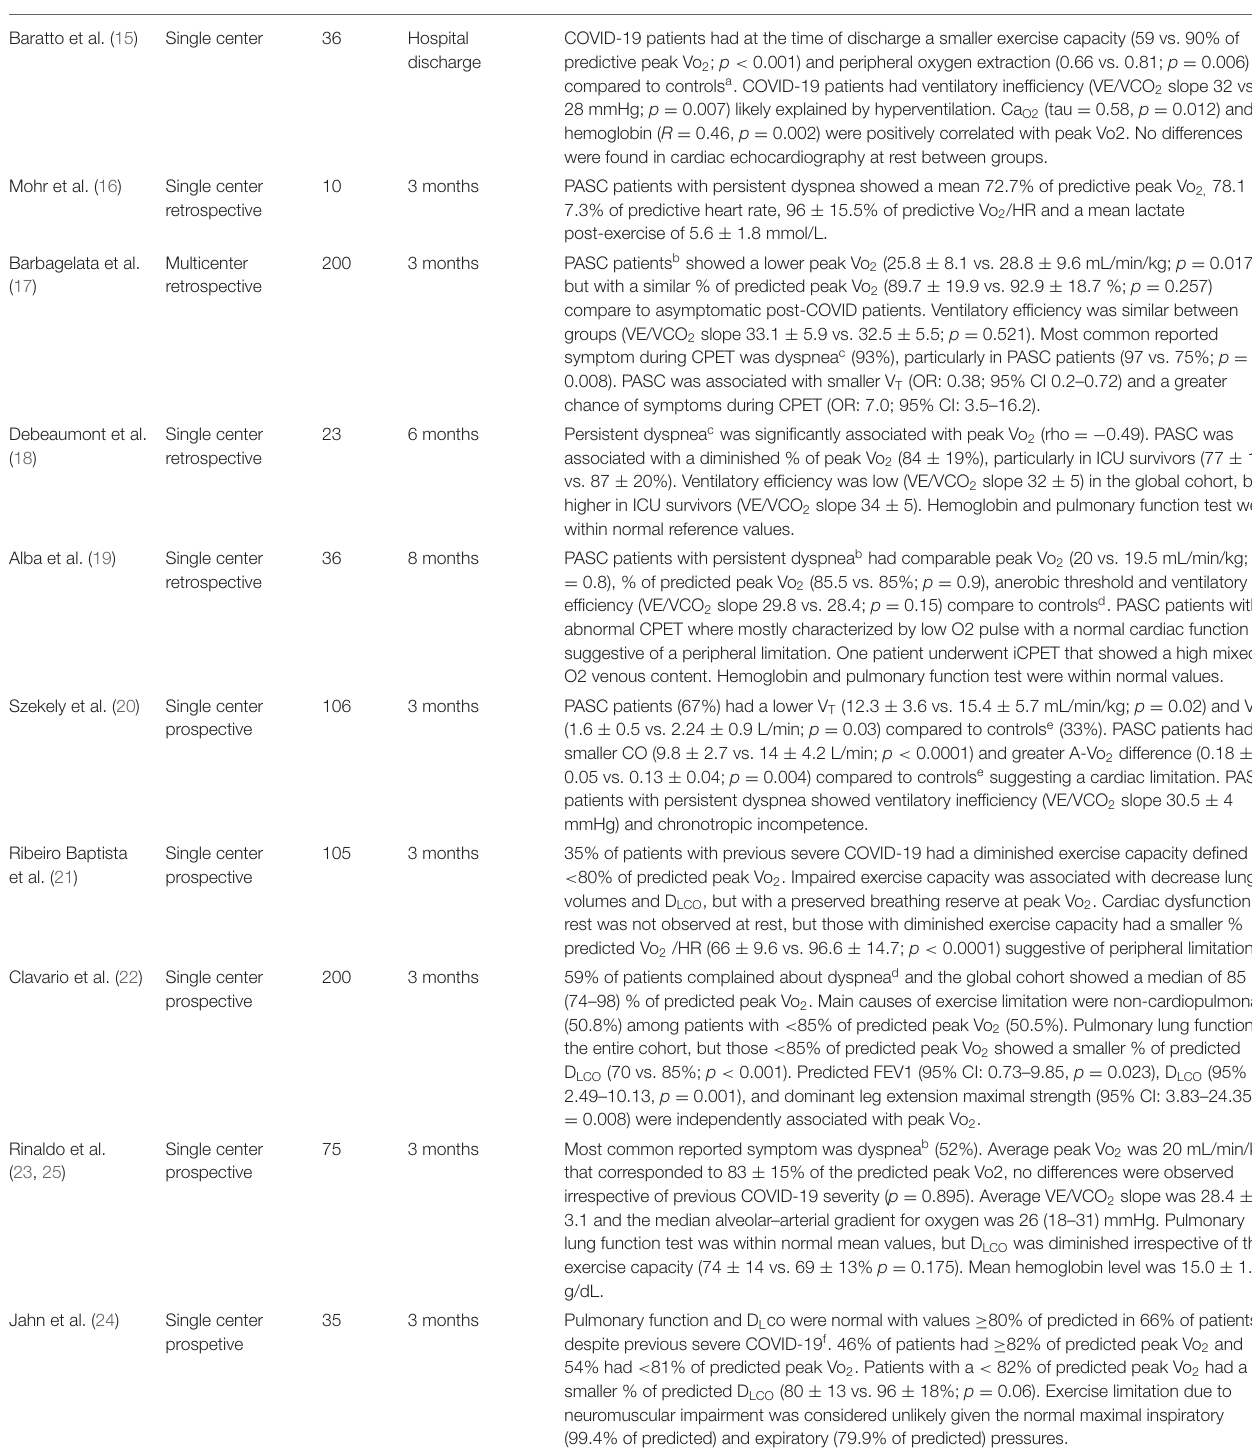
TABLE 1 | Most Relevant Studies evaluating exercise capacity in Post-acute sequelae of COVID-19 with cardiopulmonary exercise